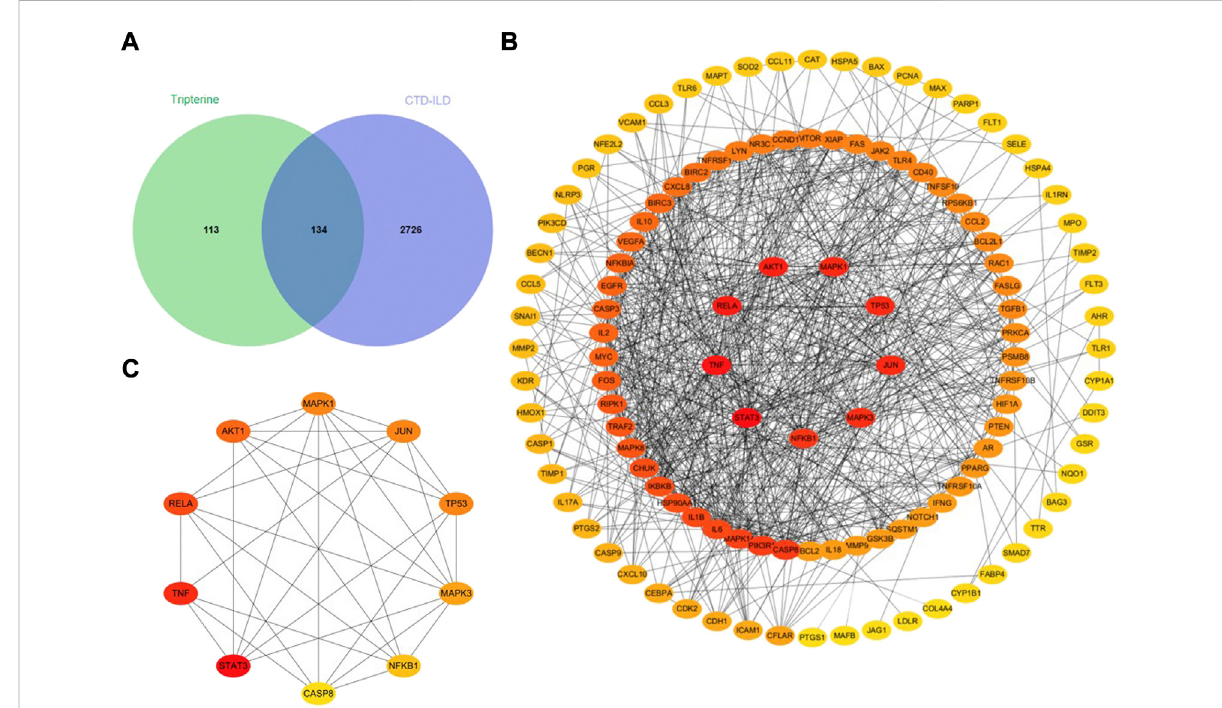
FIGURE 2 Analysis of the intersection targets of tripterine in the treatment of connective tissue disease-related interstitial lung disease (CTD-ILD). (A) A Venn diagram of the intersection targets between tripterine and CTD-ILD. (B) Topological analysis of the tripterine targets in the treatment of CTD- ILD. (C) Topological analysis of the top 10 targets of CTD-ILD treated with tripterine (different colours represent the varied importance in the network; red represents more importance, while yellow represents lesser importance).